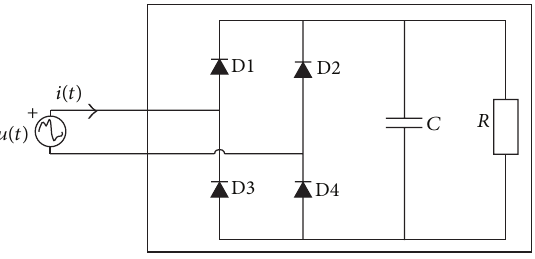
Figure 2: Nonlinear circuit with 𝑛 -sinusoidal